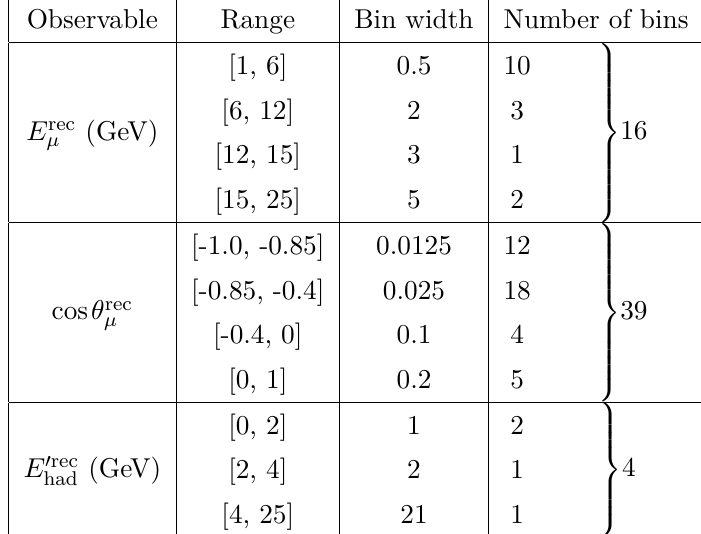
, cos θ rec , and E 0 rec for both reconstructed µ − and µ + . µ µ had